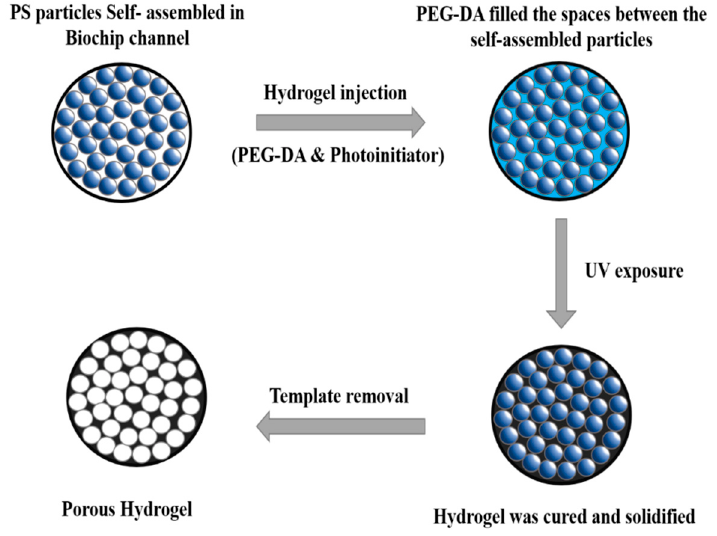
Figure 2. Schematic representation of the step-by-step formation of porous hydrogel.